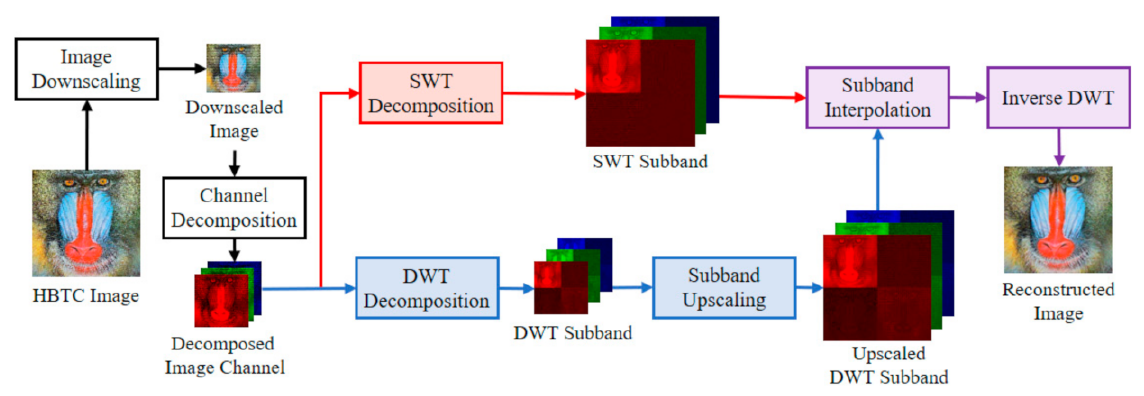
Figure 3. Schematic diagram of wavelet-based H-BTC image reconstruction